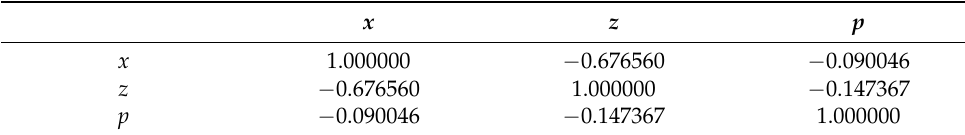
Table 3. Sample correlation coefficient matrix converted data.